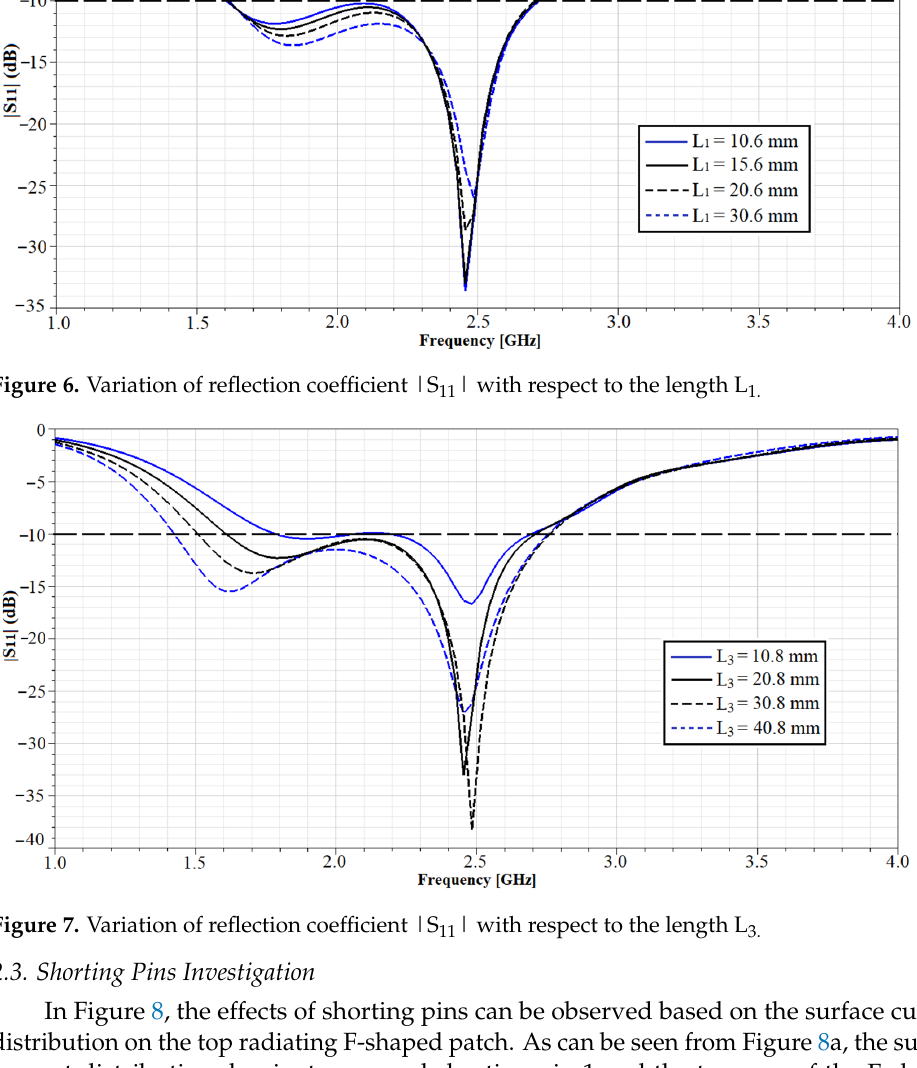
11 | with respect to the length L